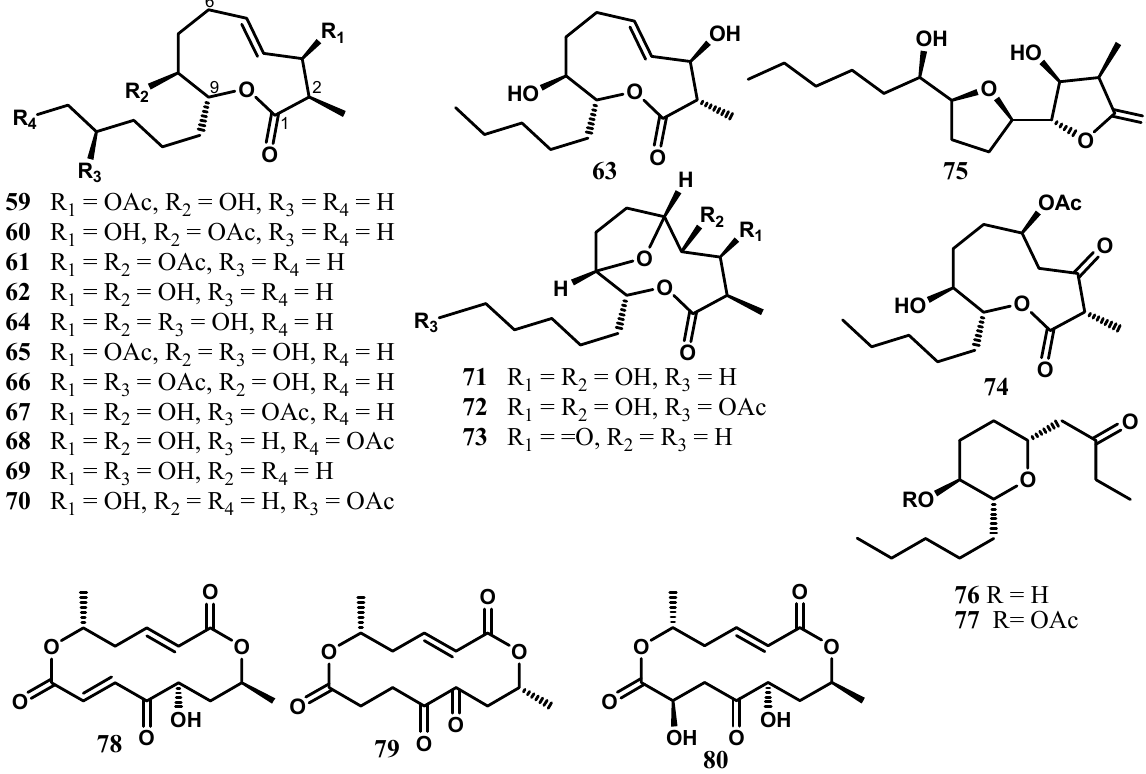
Figure 6. Nonanolides and macrocyclic dilactones from the genus Cytospora .